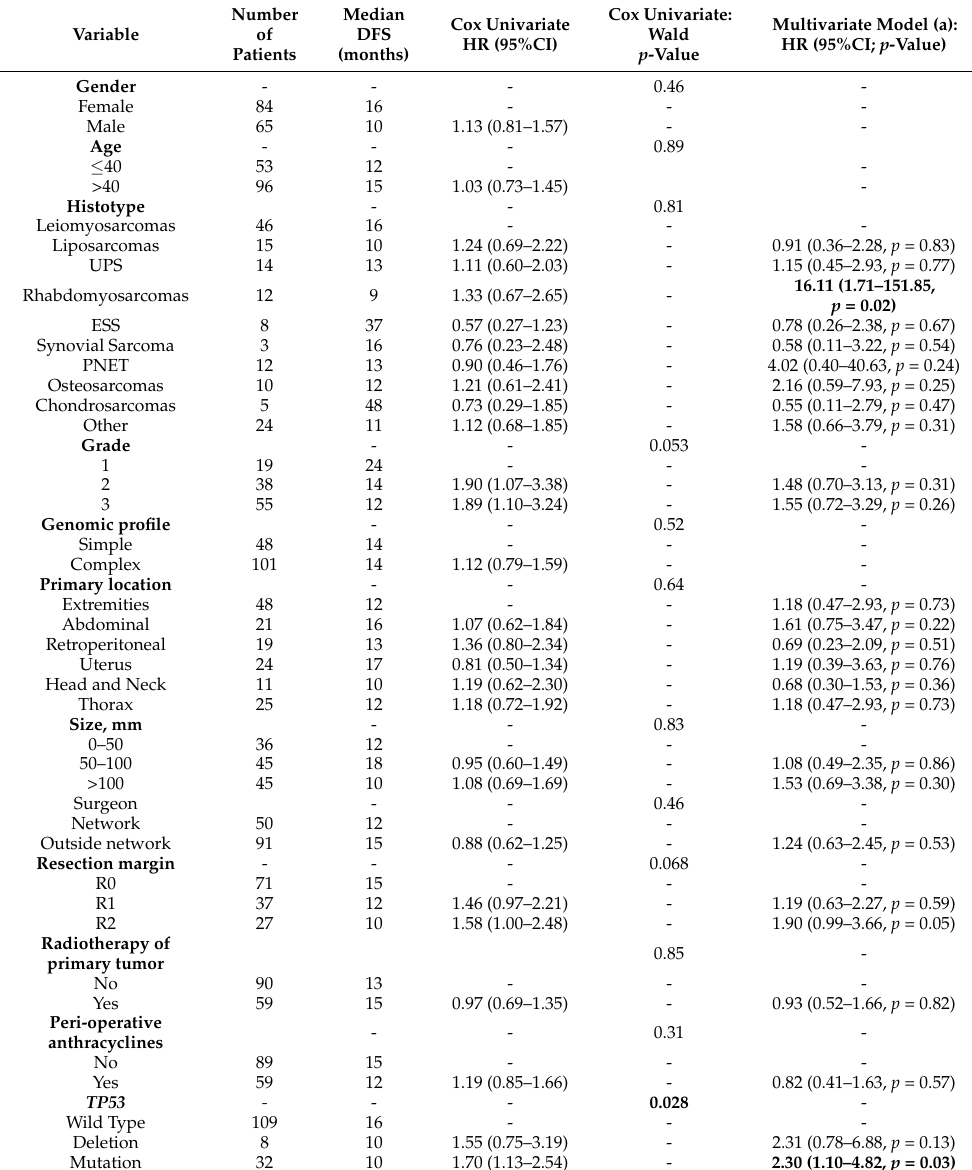
Table 2. Disease-free survival according to clinical and molecular characteristics in localized surgically resected